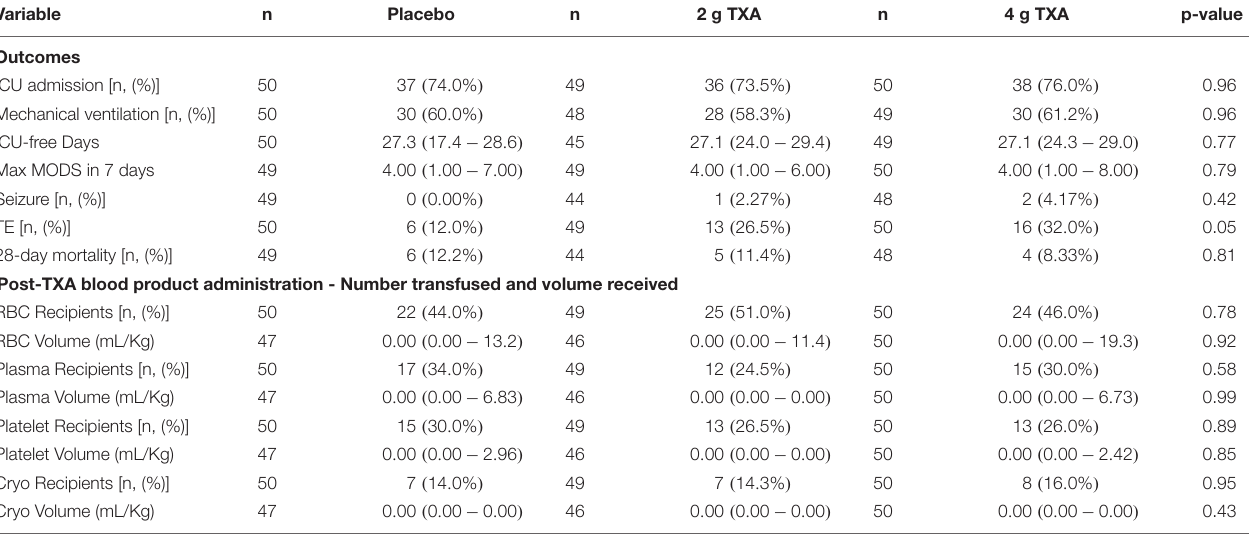
TABLE 2 | Blood product usage and clinical outcomes in all three treatment